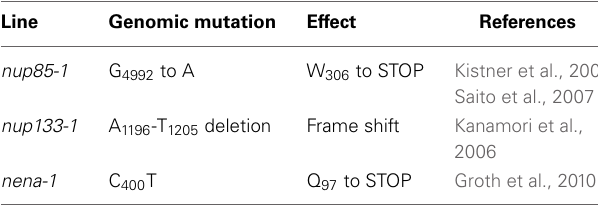
Table 1 | Analyzed L. japonicus nucleoporin mutant